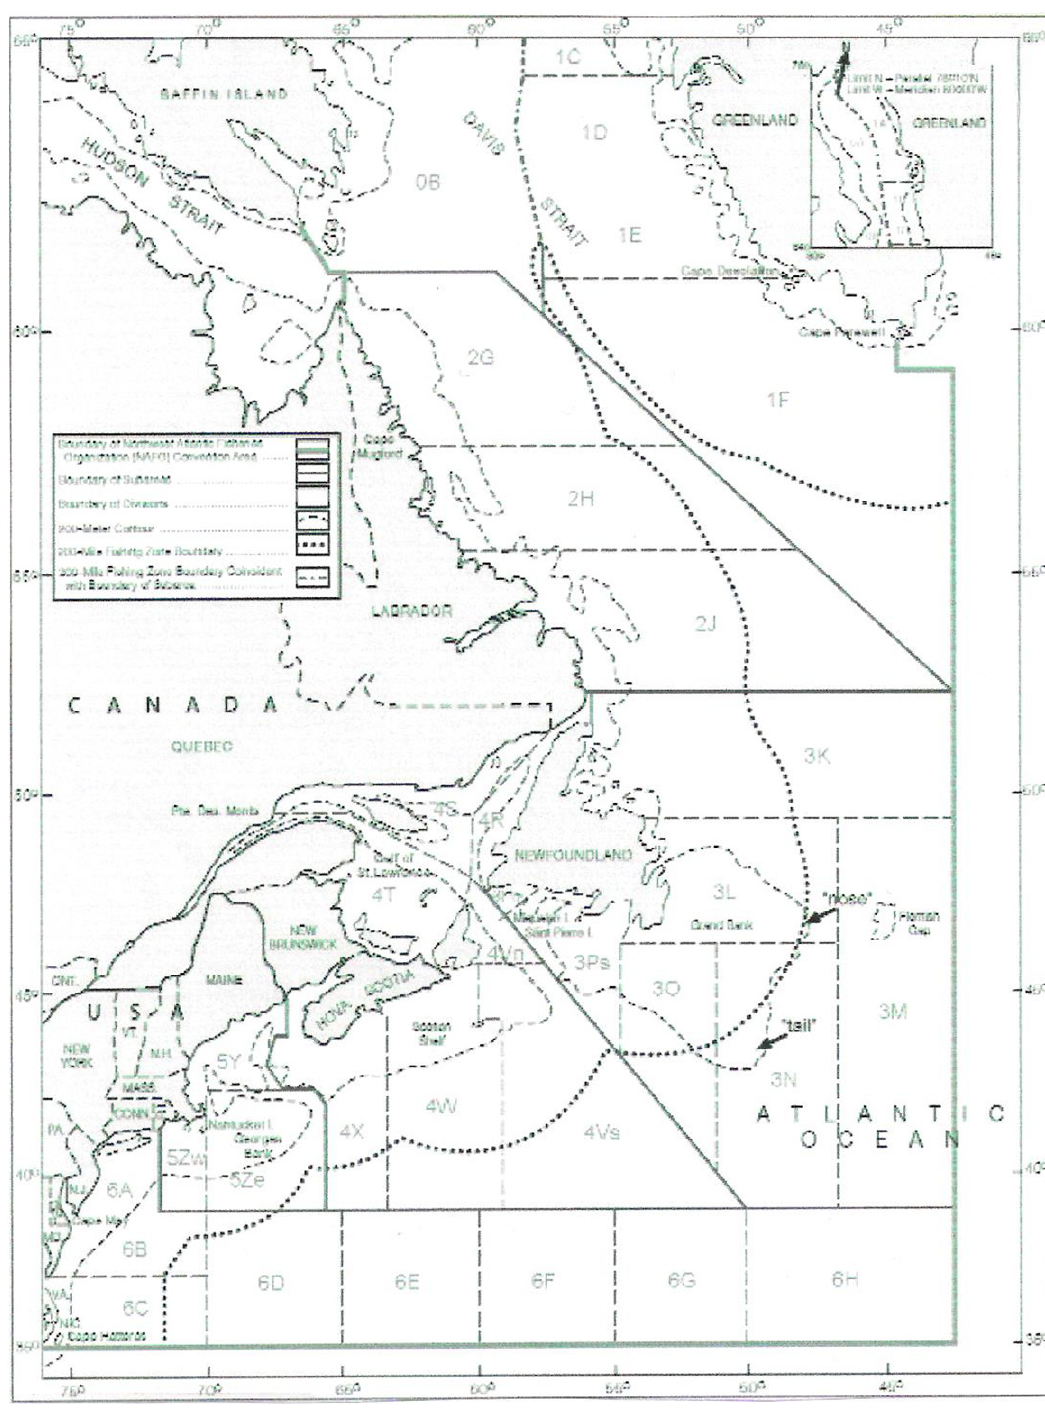
Fig 1. Map of NAFO fi shing area; Grand Banks, Newfoundland. Source: Department of Fisheries and Oceans (DFO (cid:1)